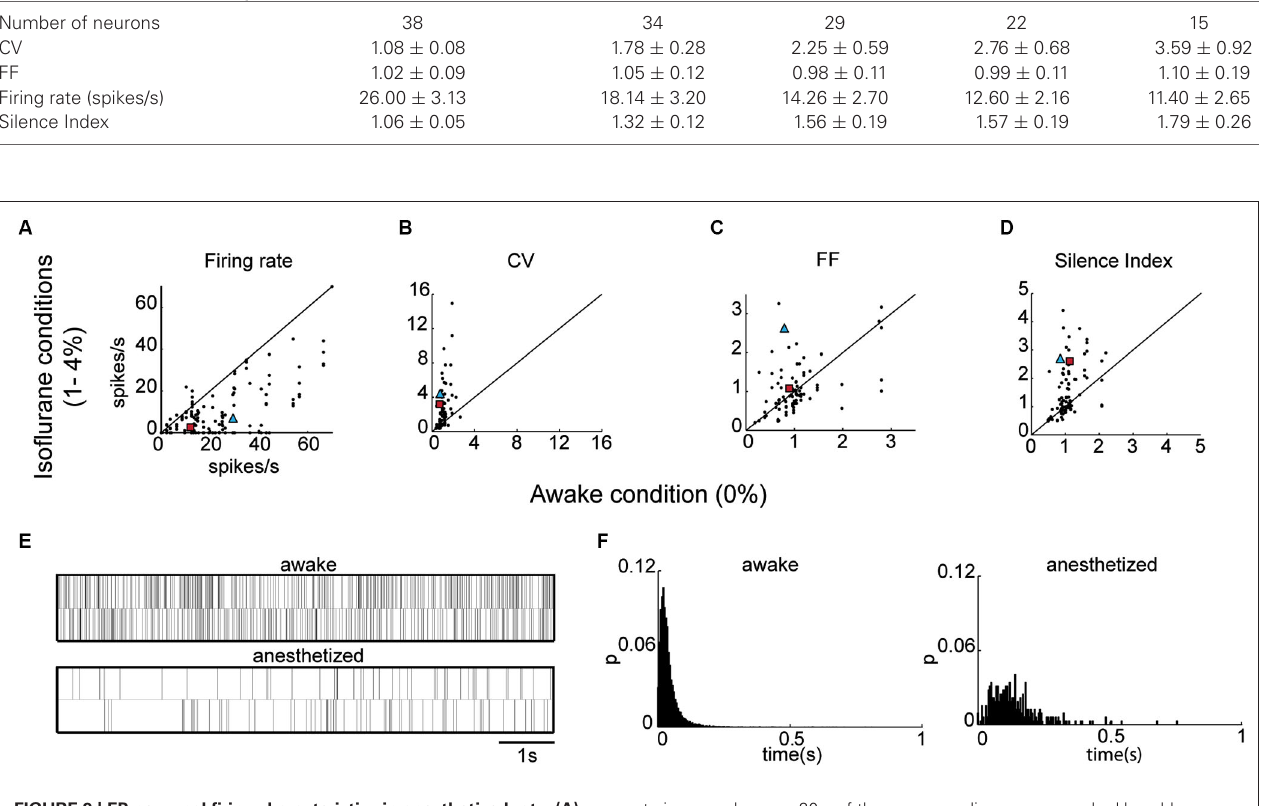
FIGURE 3 | EP neuronal firing characteristics in anesthetized rats. (A) Firing rate under anesthesia vs. firing rate during the awake state. (B–D) Same as A for CV (B) , FF ( C ) and Silence Index (D) . (E) Representative spike